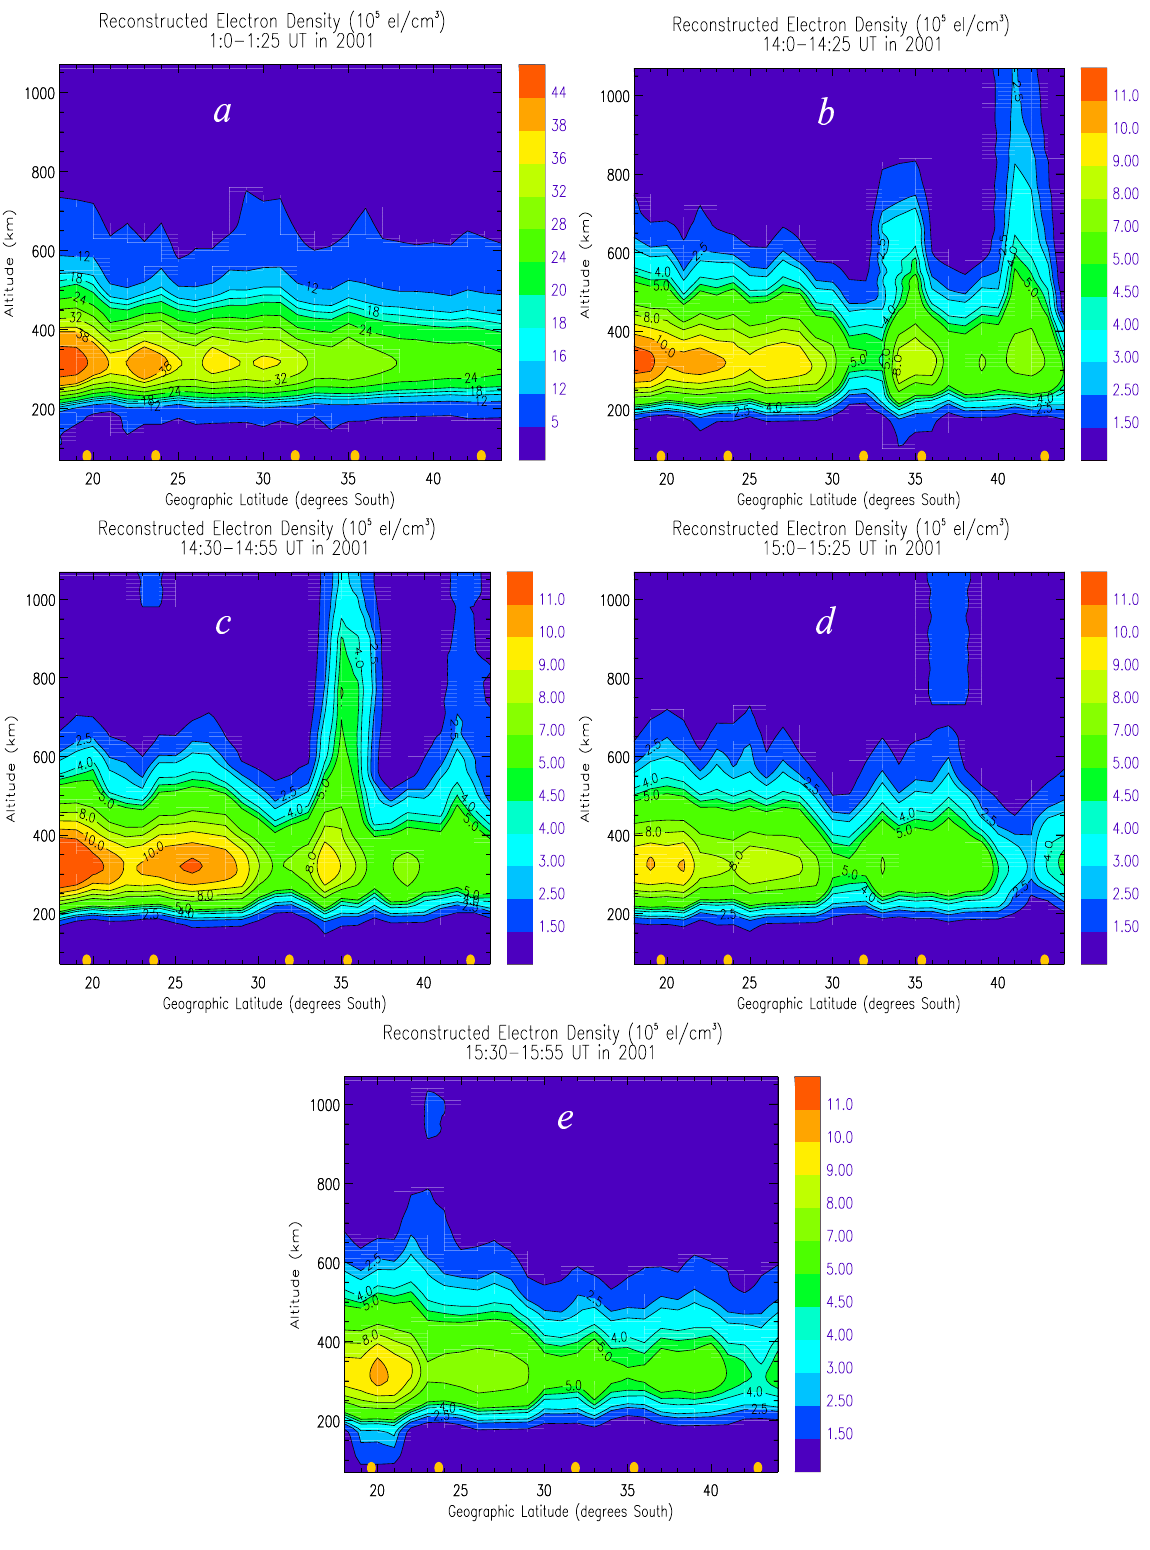
Fig. 6. Tomographic reconstructions for ground-based GPS TEC data recorded at the five stations in the Australian region on 31 March